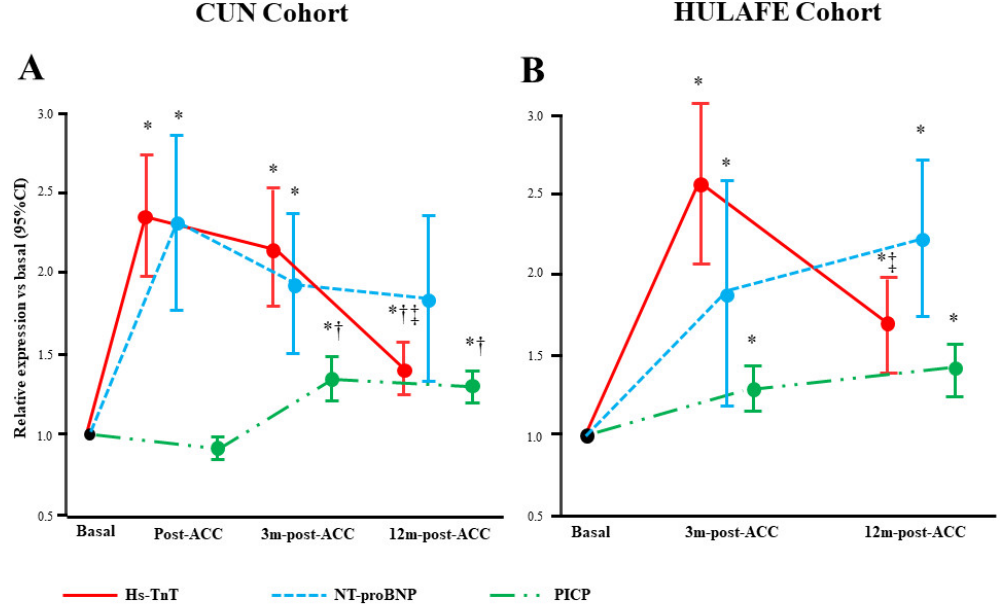
Figure 3. Biomarker levels at different visits until 12 months post-ACC in BC patients. Data are biomarker fold change levels relative to baseline values in the CUN ( A ) and HULAFE ( B ) cohorts, expressed as the estimated marginal means and 95% confidence interval (CI) after linear mixed regression analyses. * p < 0.01 vs baseline, † p < 0.01 vs. completion of ACC (post-ACC), ‡ p < 0.01 vs. 3 months post-ACC. BC, breast cancer; ACC, anthracycline-based cancer chemotherapy; NT-proBNP, amino-terminal pro-brain natriuretic peptide; hs-TnT, high-sensitivity troponin T; PICP, procollagen type-I C-terminal propeptide.